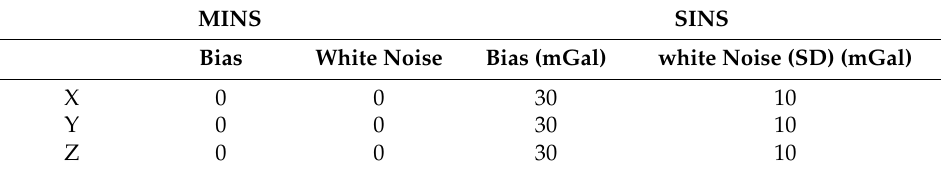
Table 6. Parameters of the accelerometer noises used in the simulation system.